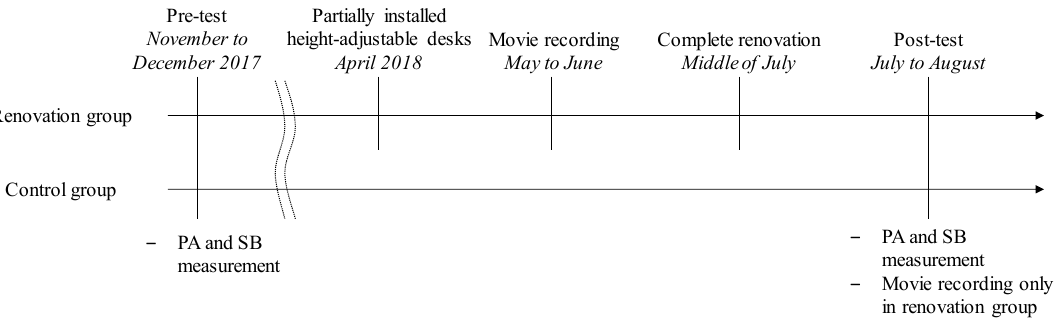
Figure 1. Flow of the study. PA: physical activity; SB: sedentary behavior.